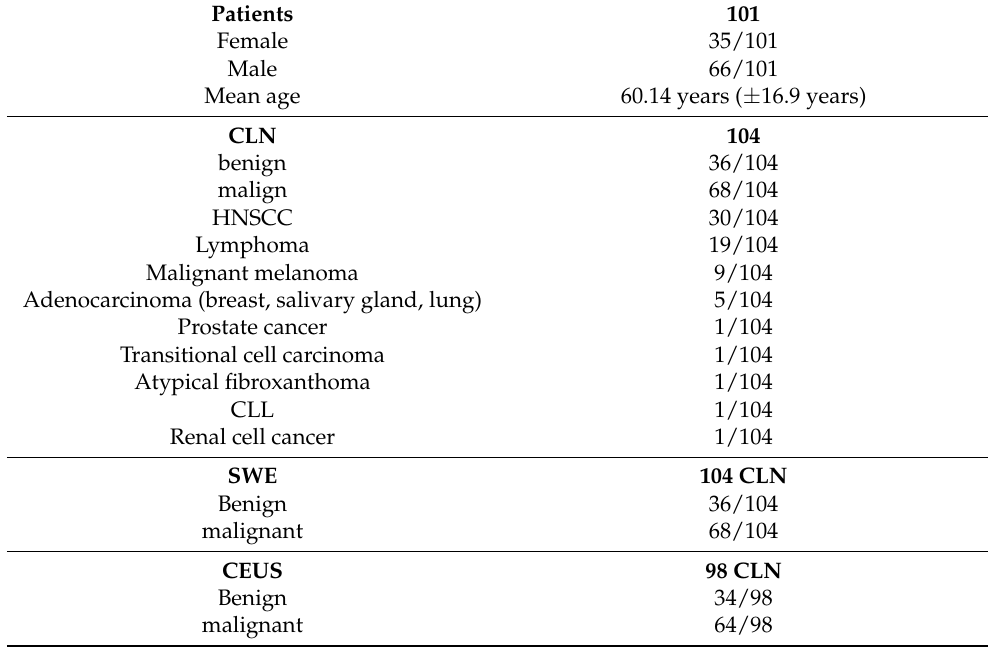
Table 1. Study Population. Abbreviations: HNSCC, head and neck squamous cell carcinoma; CLL, chronic lymphocytic leukemia; SWE, shear wave elastography; CEUS, contrast enhanced ultrasound, CLN, cervical lymph nodes. Continuous variables are given as mean (SD), categorical variables are given as absolute/total numbers (n/N), and percentages in brackets.